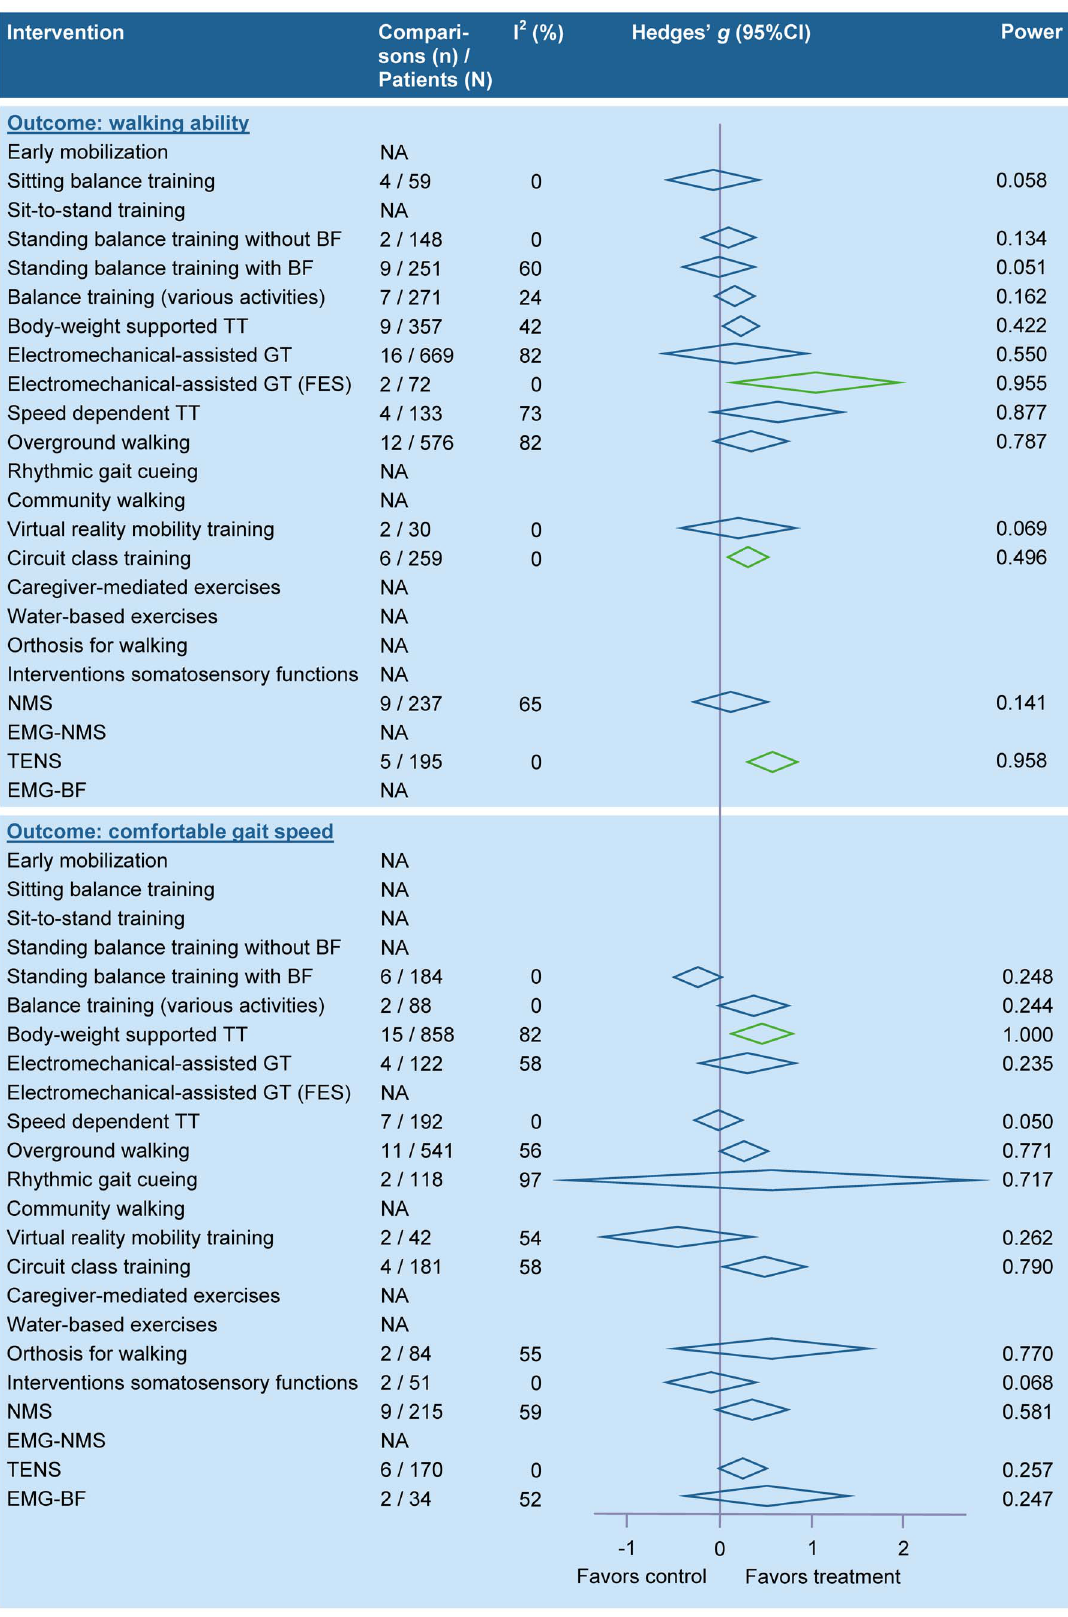
Figure 2. Summary effect sizes for physical therapy interventions – gait and mobility-related functions and activities. Legend: A green colored diamond indicates that the summary effect size is significant, while a blue colored diamond indicates that the summary effect size is